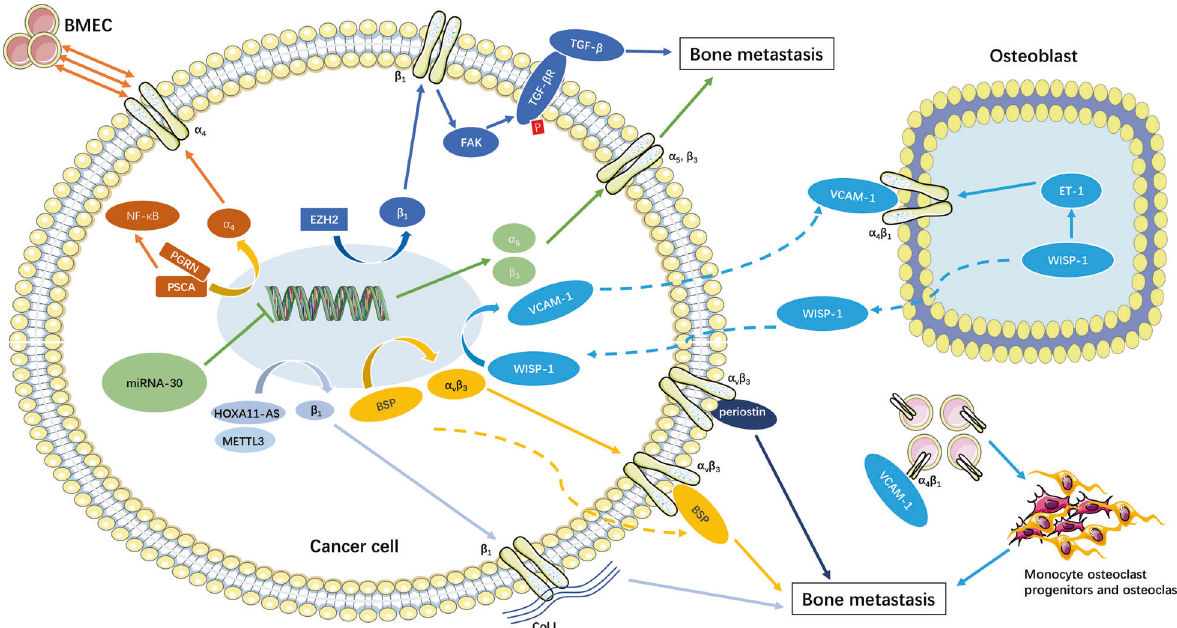
Fig. 6 Schematic diagram of integrins regulating bone metastasis of cancer cells. High expression of Lnc HOXA11-AS, METTL3, and EZH2 in cancer cells increased the transcription level of integrin β 1 . Integrin β 1 promoted bone metastasis through its high af fi nity with type I collagen and the FAK/TGF- β pathway. PSCA interaction with PGRG increased integrin α 4 transcription levels and activated NF- κ B, which promoted cancer cell af fi nity with BMECs. The miRNA-30 family inhibited integrin α 5 and β 3 transcription, The miRNA-30 family inhibited integrin α 5 and β 3 transcription, thereby attenuating bone metastasis of cancer cells. High expression of BSP in cancer cells increased integrin α and promoted bone metastasis by binding to integrin α v β 3 as a ligand. Osteoblast-derived WISP-1 increased integrin α 4 β 1 expression and induced cancer cells to overexpress VCAM-1. VCAM-1 binding with integrin α 4 β 1 enhanced the adhesion of cancer cells to bone tissue. In addition, VCAM-1 activated in the micrometastasis microenvironment adhered to integrin α 4 β 1 -positive osteoclast progenitors, leading to local recruitment of osteoclast progenitors and osteoclasts in the bone, which exacerbates